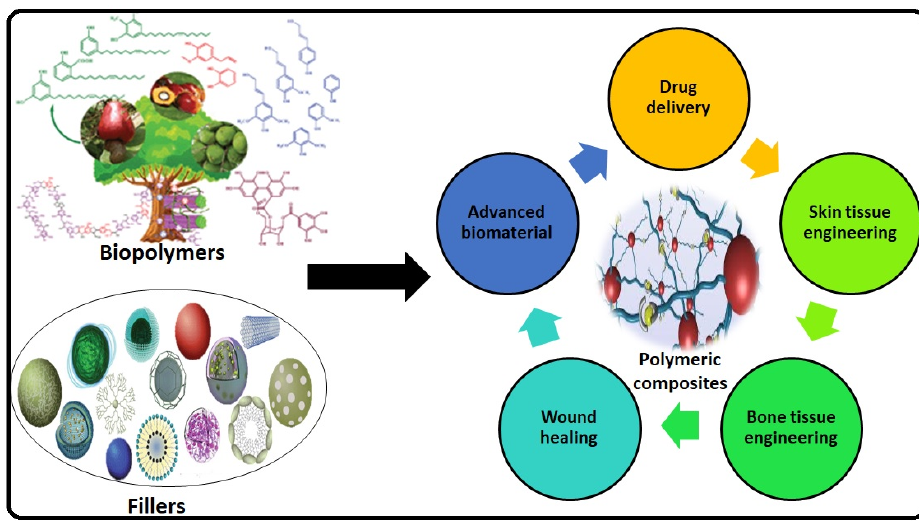
Figure 1. Graphical abstract that describes the different potential application of biopolymers with different